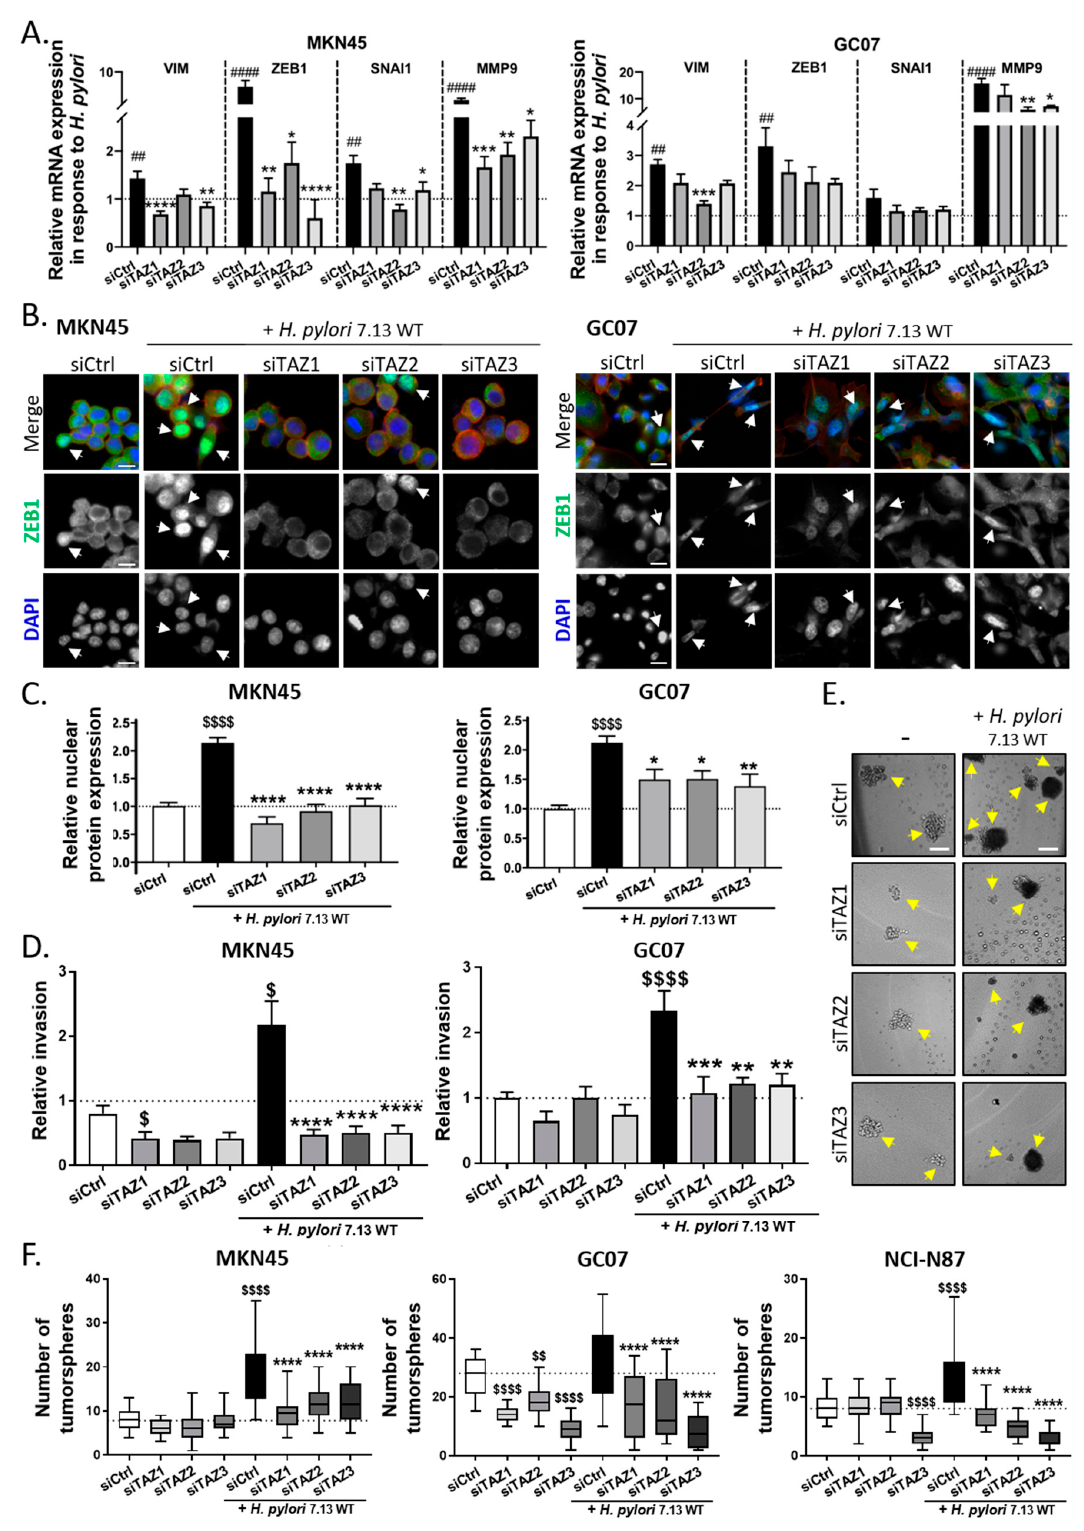
Figure 4. TAZ conferred epithelial–mesenchymal transition (EMT) phenotype and cancer stem cell (CSC)-like properties in response to H. pylori. ( A ) Relative mRNA expression of EMT markers Vimentin (VIM), ZEB1, Snail family transcriptional repressor 1 (SNAI1), and Matrix metallopeptidase 9, (MMP9) measured by RT-qPCR in MKN45 and GC07 cells, presented as the ratio of mRNA expression in H. pylori- infected vs. uninfected cells for each condition of silencing RNA (siRNA) transfection. Bars represent mean fold changes ± SEM of 4–6 independent experiments relative to